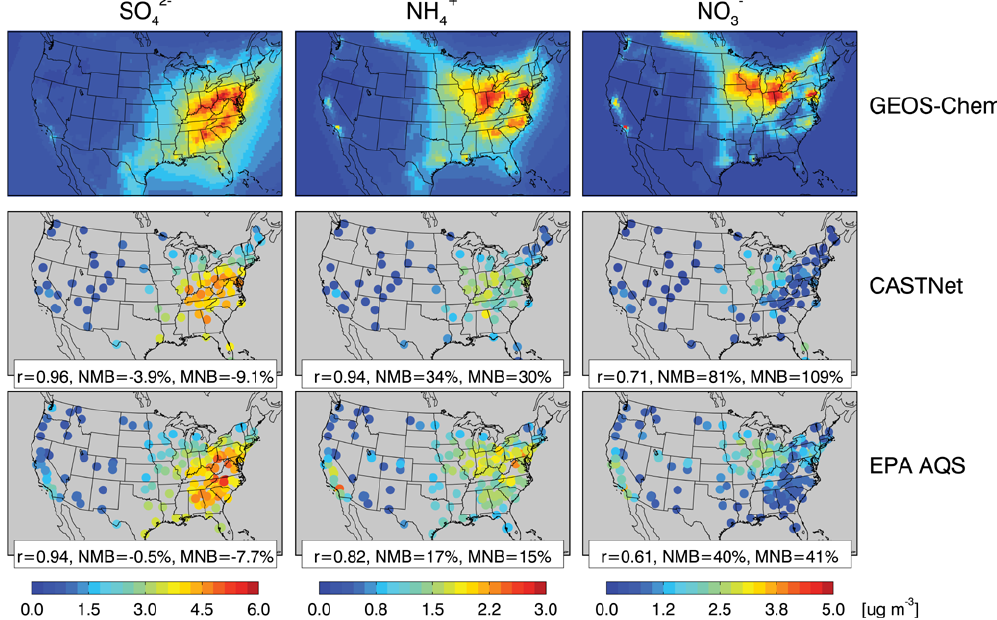
Fig. 5. Annual mean concentrations of sulfate (left), ammonium (middle), and nitrate (right) aerosol in surface air in 2006. Results from the GEOS-Chem model (top) are compared to observations from CASTNet (middle), and EPA AQS (bottom). Statistics for model comparisons to observations are shown inset as correlation coefficients ( r) , normalized mean biases (NMB), and mean normalized biases (MNB).